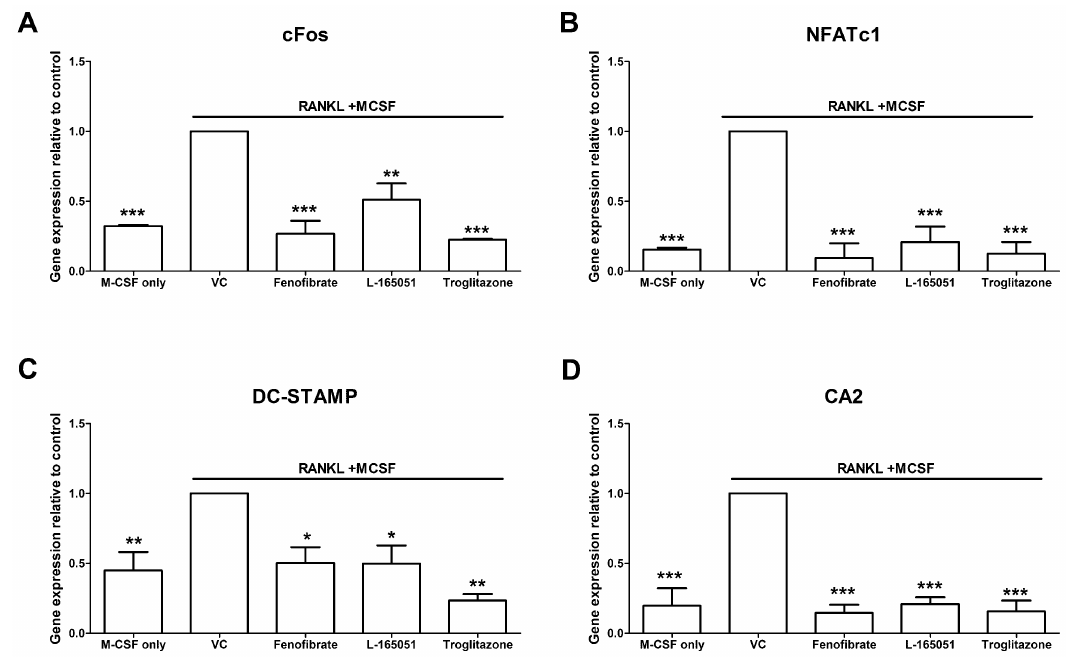
Figure 6. Effect of PPAR agonists on osteoclast specific gene expression. CD14+ monocytes were seeded into 24-well and exposed to PPAR agonists in the presence of RANKL (30 ng mL − 1 ) and M-CSF (25 ng mL − 1 ) for 14 days. Expression of ( A ) cFos, ( B ) NFATc1, ( C ) DC-STAMP and ( D ) CA2 was determined by qPCR. VC: vehicle control. * p < 0.05, ** p < 0.01, *** p < 0.001 vs. vehicle control.